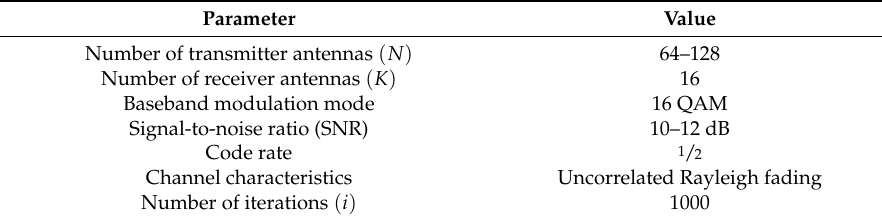
Table 2. Simulation parameters.